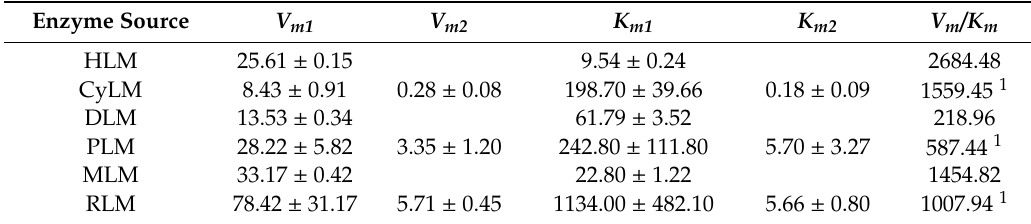
Table 2. Kinetic parameters of NCMN -O- demethylation in liver microsomes from di ff erent species. Enzyme